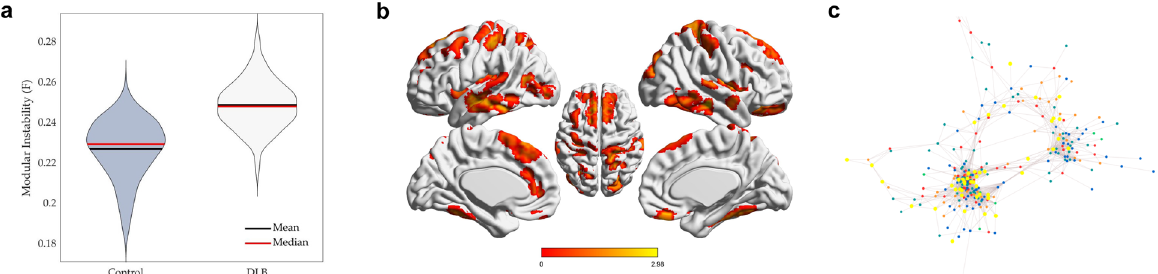
Fig. 3 DLB is characterised by increased modular instability. a DLB regions had signi fi cantly increased modular instability ( fl exibility) relative to controls ( P < 0.001). b Areas of increased fl exibility (FDR < 0.1) included boundary regions between modules as well as distributed diffusely throughout inferior and middle temporal, left medial frontal and post-central parietal regions. c Force-directed plot of areas of signi fi cantly increased instability (yellow dots; FDR < 0.05) in relation to communities (shown in smaller coloured dots – green, blue, red) demonstrates these regions are spread diffusely throughout different modules both embedded in high-degree communities as well as at the junction points between